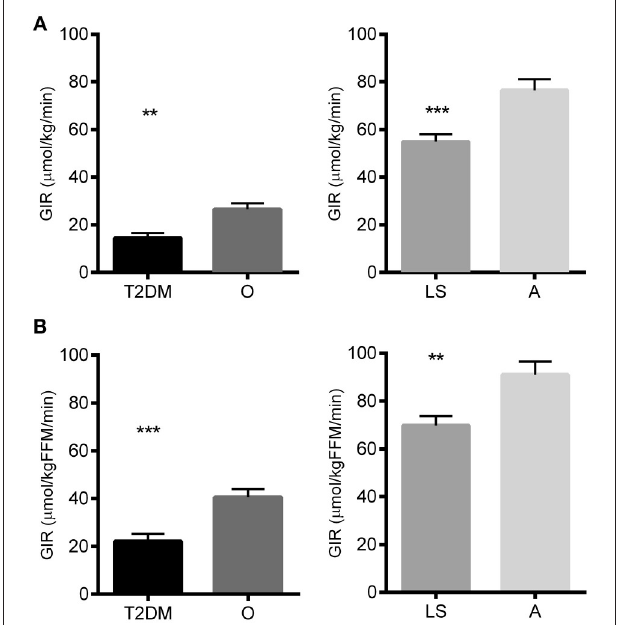
FIGURE 1 | Glucose infusion rate (GIR) during the glucose clamp as a measure for peripheral insulin sensitivity in type 2 diabetes patients (T2DM), non-diabetic overweight/obese individuals (O), lean sedentary individuals (LS) and endurance-trained athletes (A) Glucose Infusion rate normalized to total body weight. (B) Glucose infusion rate normalized to the lean body mass. Significance is indicated with ** and *** representing p < 0.01 and p < 0.001 respectively. Graphs represent mean ± SEM.